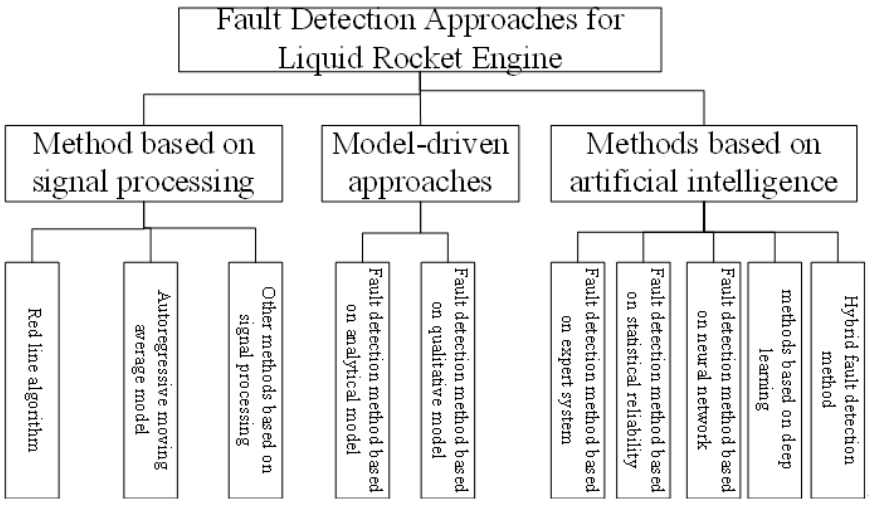
Figure 1. Fault detection approaches for LRE.